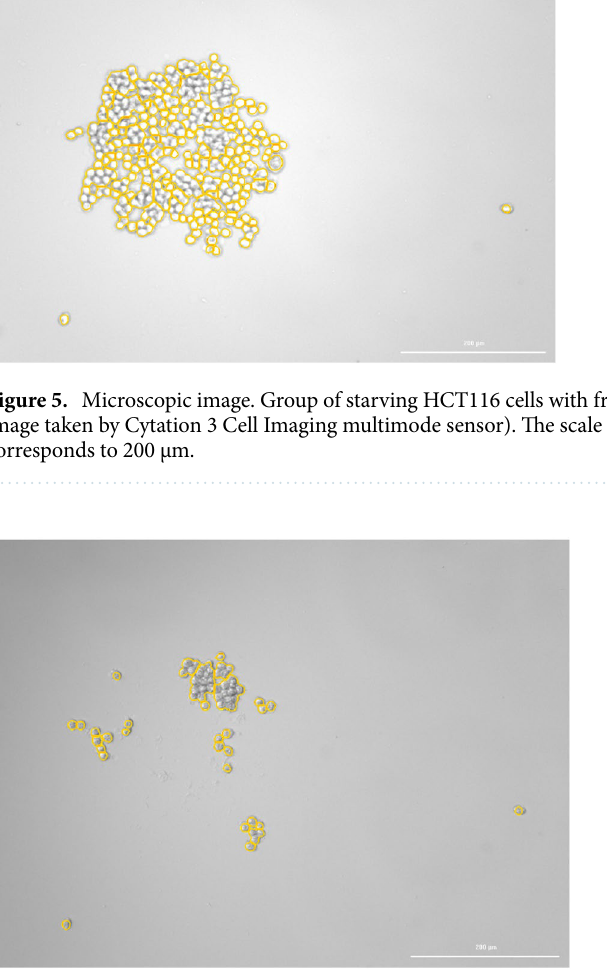
Figure 6. Microscopic image. The same field of view as in Fig. 5 after the cells were exposed to combination saline solution and HES at a ratio of 3:7. After T + 30 s, the cells detach and, for most part, float away from the field of view (bright field image taken by Cytation 3 Cell Imaging multimode sensor). The scale bar on bottom right of the picture corresponds to 200